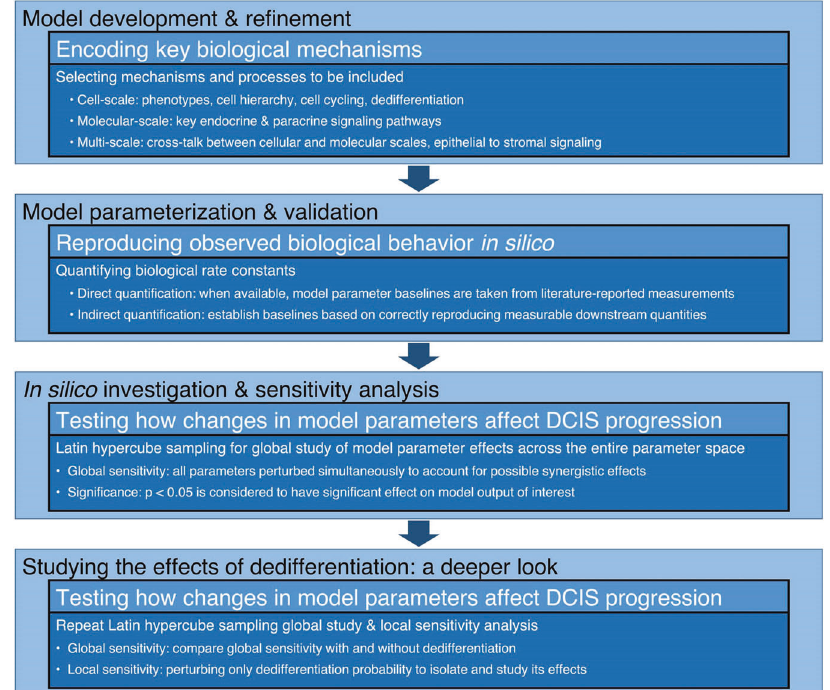
Fig. 2 Study fl owchart. A graphical description of the study is shown. Brie fl y, after identifying key biological and physical processes and phenotypic and signaling hierarchies to be included in the model, the model was extensively tested to phenomenologically quantify model parameters that were unavailable in the literature, based on successful reproduction of literature-reported measurements. The full parameter space was examined using Latin hypercube sampling (LHS) parameter perturbation, and paramters with signi fi cant effects on model outcomes were identi fi ed. Perturbation studies were repeated with and without dedifferentiation, and local and global sensitivity analysis was performed.